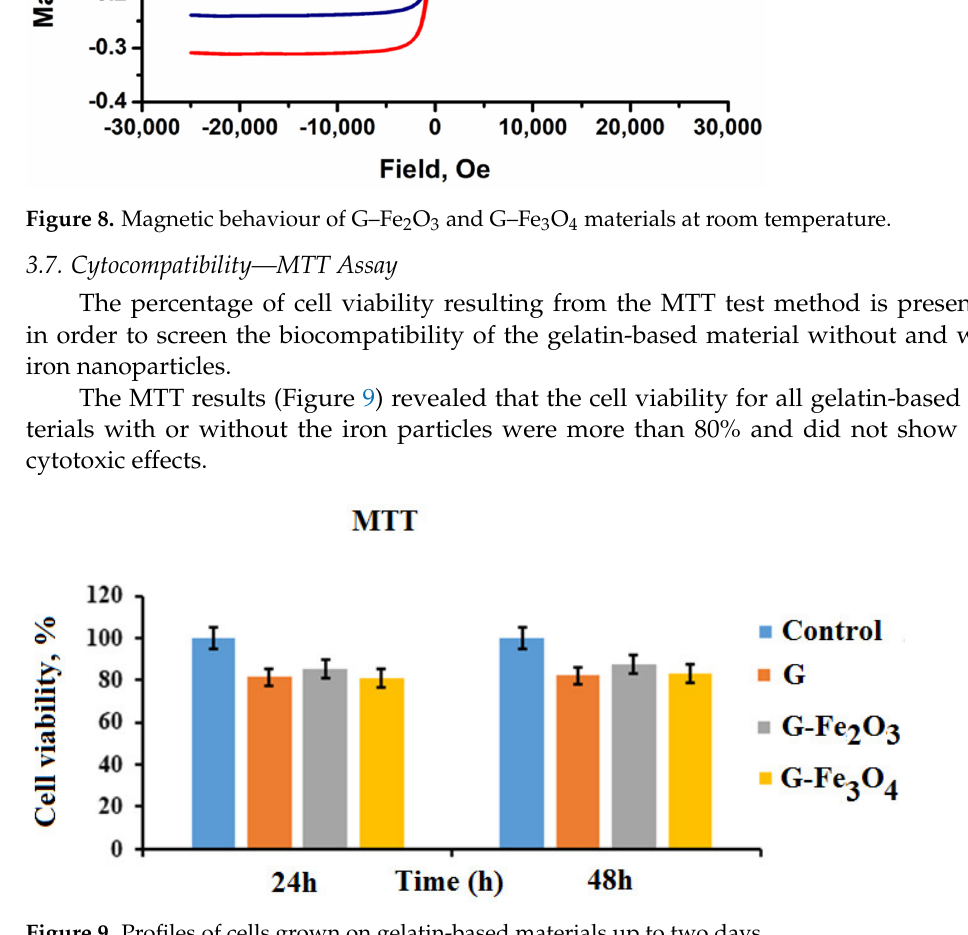
Figure 9. Profiles of cells grown on gelatin-based materials up to two days.